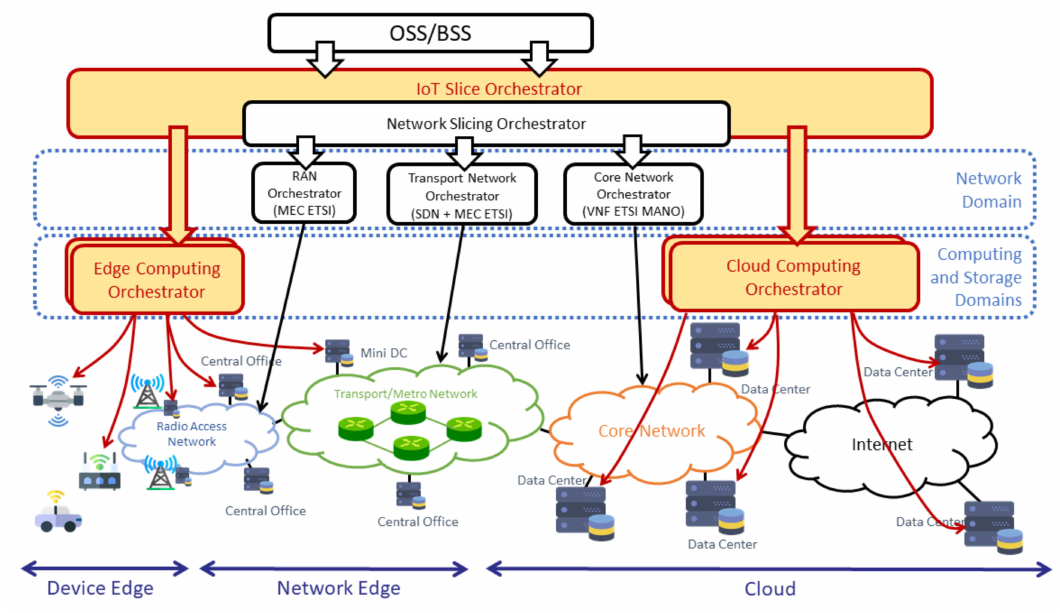
Figure 2. Overall IoT solution